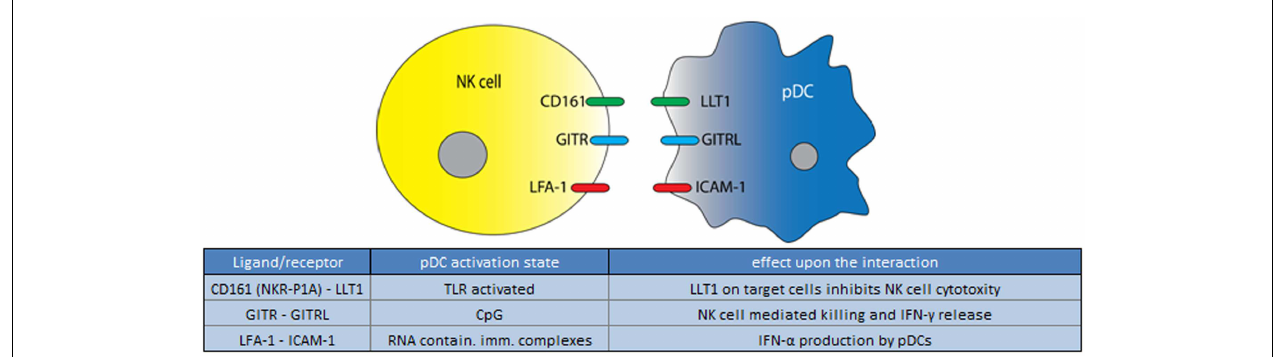
FIGURE 7 | Ligand/receptor paring of a pDC with an NK cell and the maturation state/activation stimuli associated with ligand or receptor expression on the pDC surface .